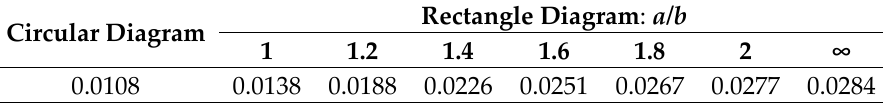
Table 1. Shape factors of rectangular and circular diagrams.